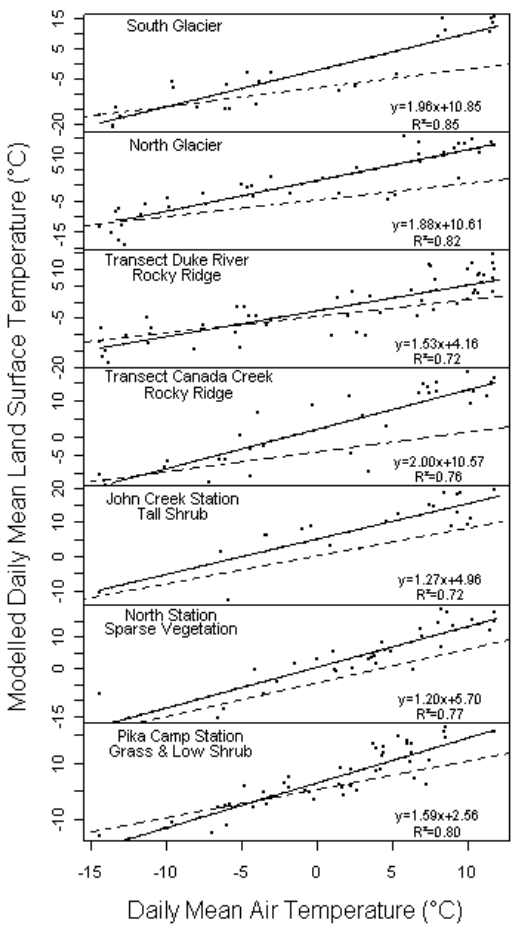
Figure 5. Modeled Mean Daily Surface Temperature (ICM) versus mean daily air temperature at non-vegetated glacier and rocky ridge locations in the flanks of the St. Elias Mountains and at vegetated sites (John Creek Station, Ruby Range North Station, and Pika Camp Station) east of Kluane Lake. The dashed lines indicate the 1:1 lines; the solid lines indicate the linear